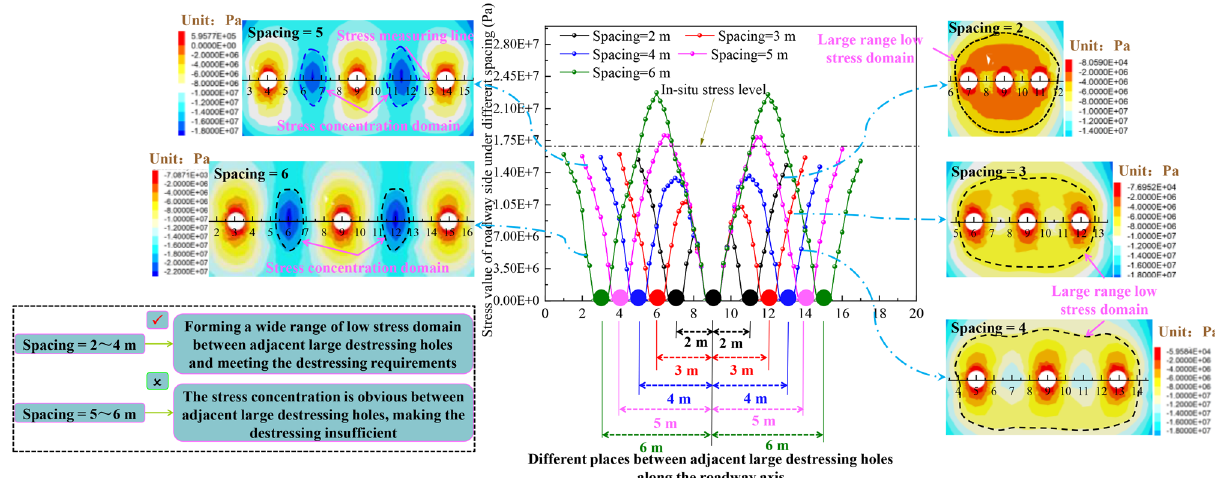
Figure 14. Curve and nephogram of stress distribution of roadway surrounding rock at different